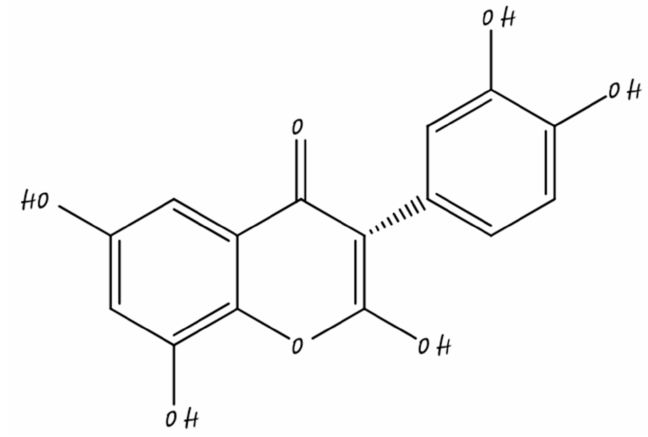
Figure 12. Quercetin.